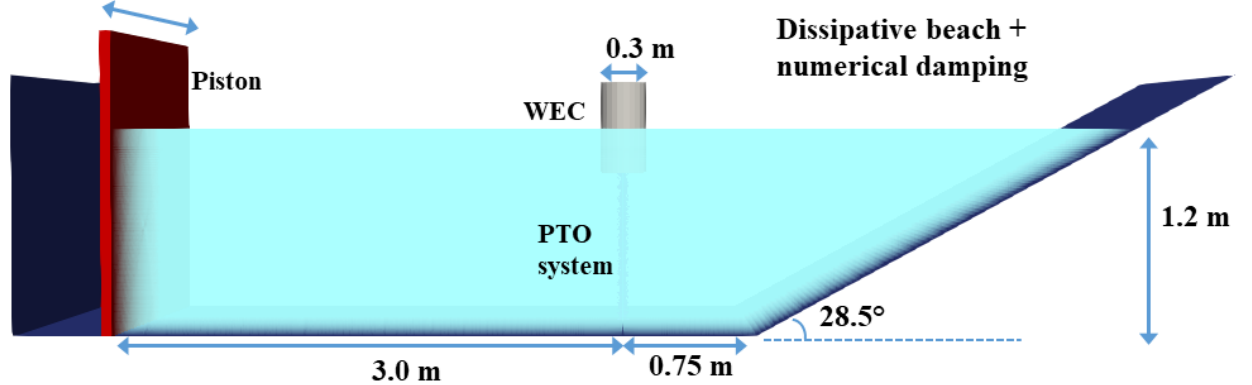
Figure 8. Dimensions of a basin for a heaving cylindrical WEC in waves with T = 1.2 s in